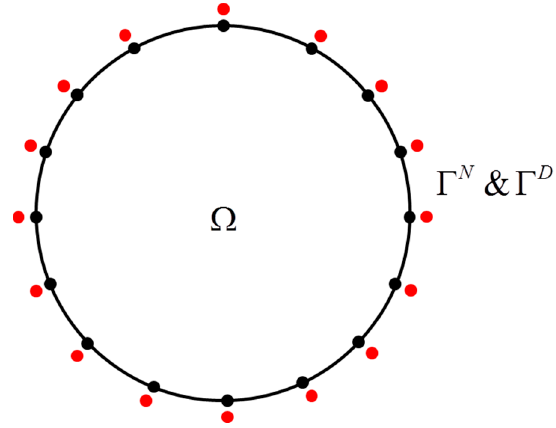
Figure 2. Schematic diagram of the ghost nodes arrangement.